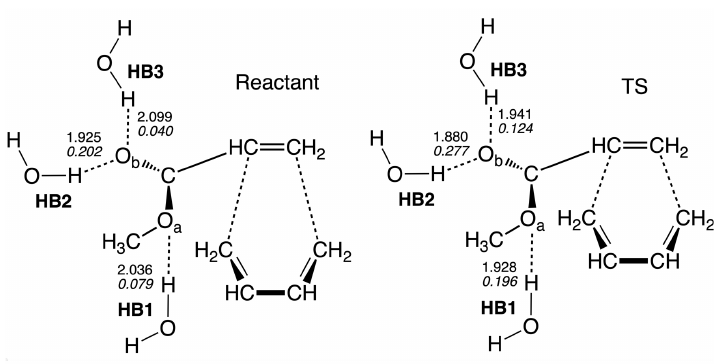
Figure 9. Local mode parameters of hydrogen bonds for the reactant and TS of the reaction R1nw . The bond lengths (Å) are shown in a normal font, the local mode force constants (mDyn/Å) are shown in an italic font. B3LYP/6-311+G(2d,p)/AMBER level of theory. Table 3. Hydrogen bond length d , local mode force constant k a , BSO , and NBO atomic charge on oxygen for the reactant and TS of the reaction R1nw . B3LYP/6-311+G(2d,p)/AMBER level of theory. Reactant